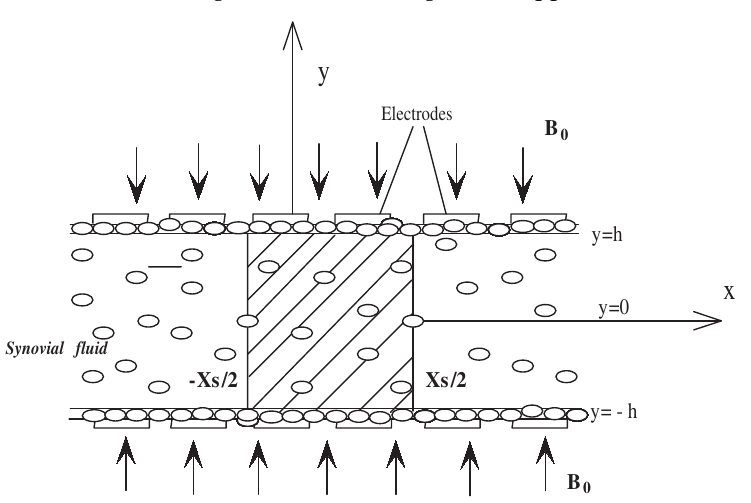
Figure 1. Physical Configuration of the human knee